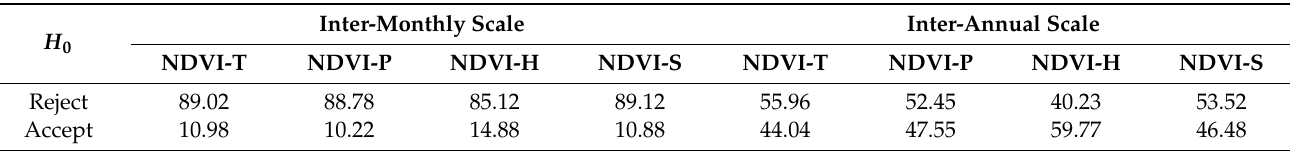
Table 3. Counts of co-integration analysis (%).